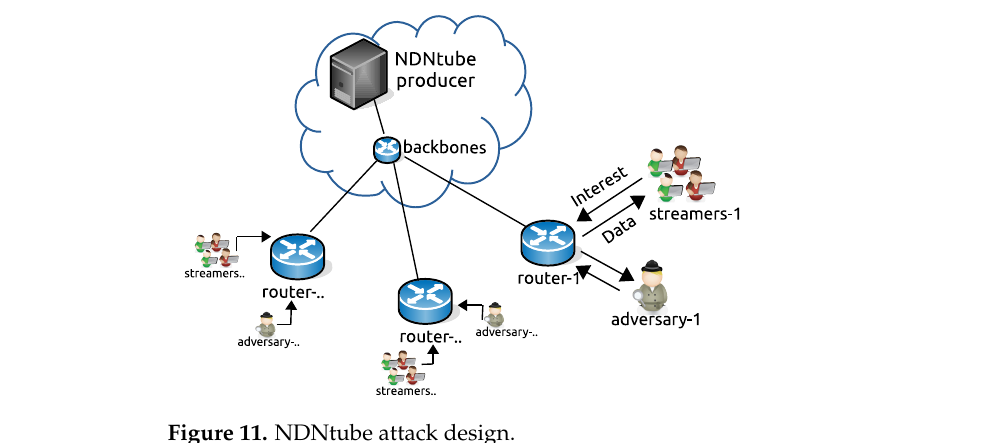
Figure 11. NDNtube attack design. Table 2. Configurations for NDNtube attack